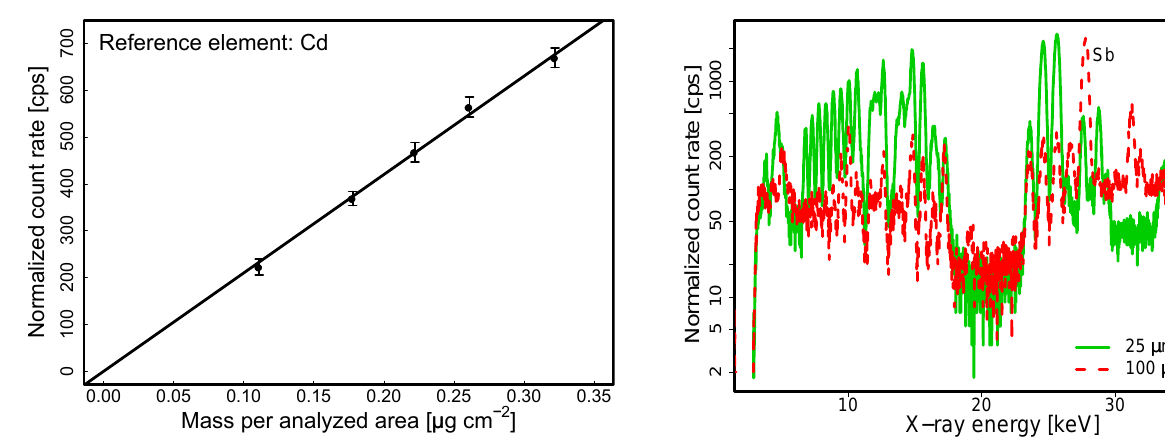
Fig. 6. Fluorescence intensity of reference element Cd: individual data points represent the average count rates (normalized to photon flux and detector dead time) for about 50 spectra of each coating on the calibration film. The absolute mass calibration factor is obtained by the slope of the linear regression (with an intercept of zero) of mean fluorescence count rates in cps versus area concentration in µgcm − 2 .